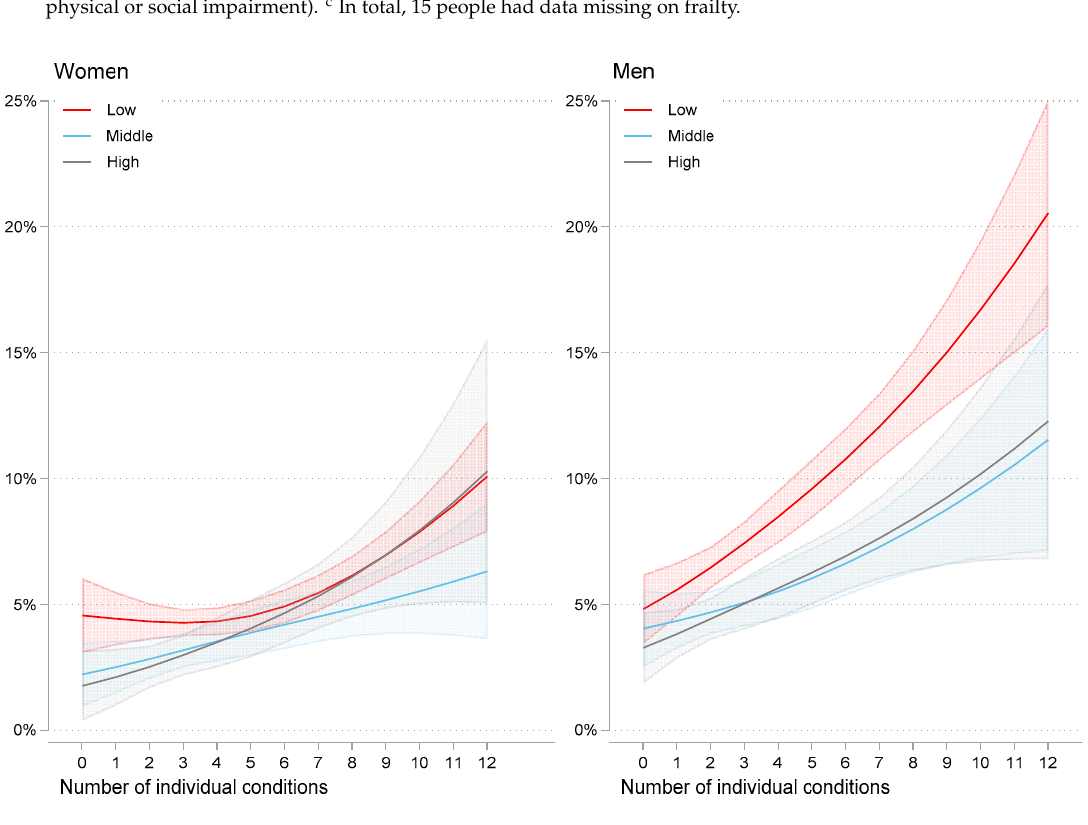
Figure 2. Estimated 10-year all-cause risk of death by number of individual long-term conditions and occupational group for women and men. Shading indicates 95% Cis. Low, middle, and high indicate occupational groups.